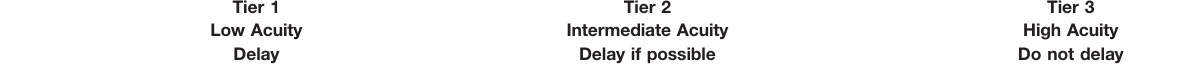
TABLE 4 | General Surgery Elective Surgery Acuity Scale (ESAS). All candidates for surgery should be assessed for surgical fi tness on an individual basis. This is an example ESAS and not comprehensive. Procedure acuity for the individual patient may shift among tiers based upon acuity of illness, severity of COVID-19 infection and coagulopathy, and hospital surgical capacity (134 – 136). For speci fi c length of operative delay, please see the text and Association of Anesthesiologists guidelines